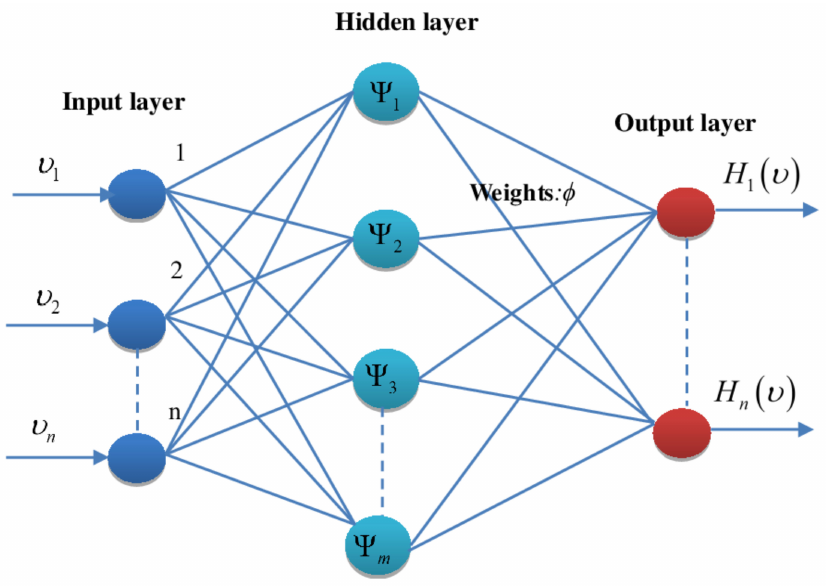
Figure 1. Structure of radial basis function neural